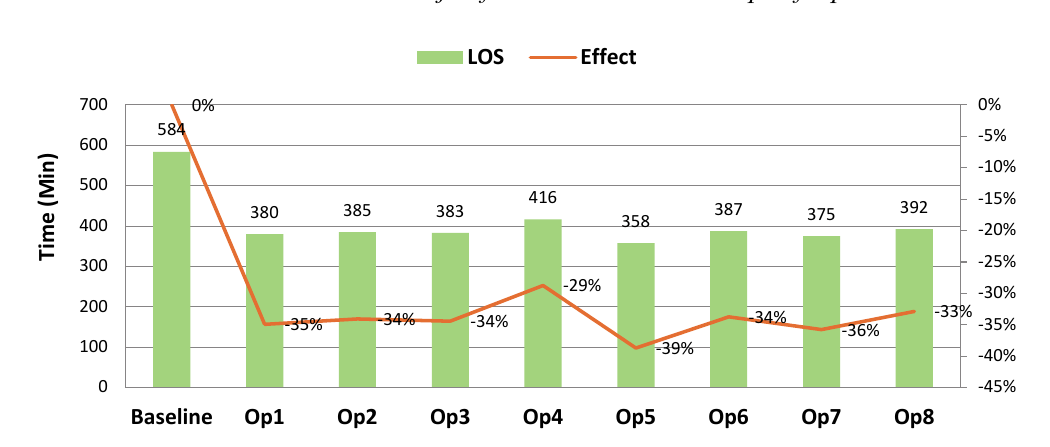
Fig. 8 . Results of patient average throughput time by using different PIT allocation options in compar- ison with the baseline measure (8hrs in busy